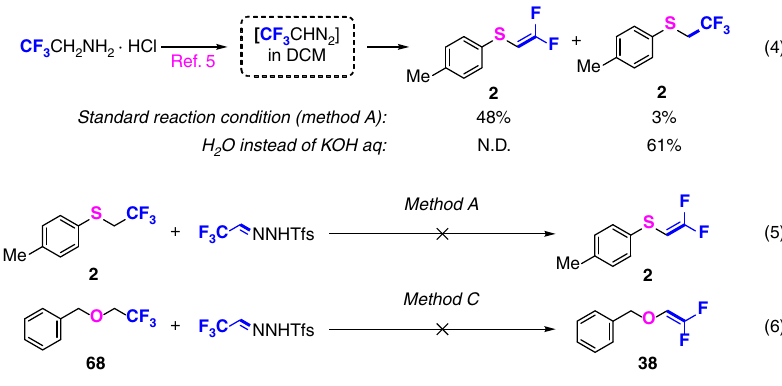
Fig. 5 Mechanistic investigations. Base promotes fl uoride elimination (4) Intermediate experience veri fi cation (5) and (6)